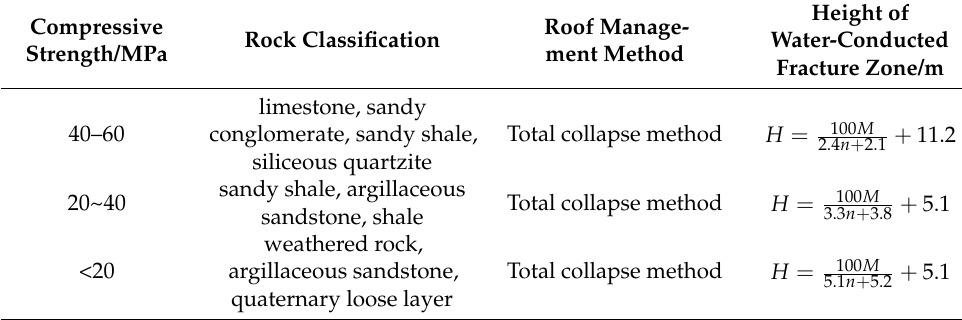
Table 1. Empirical equations for calculating the height of water-conducted fracture zone. Compressive